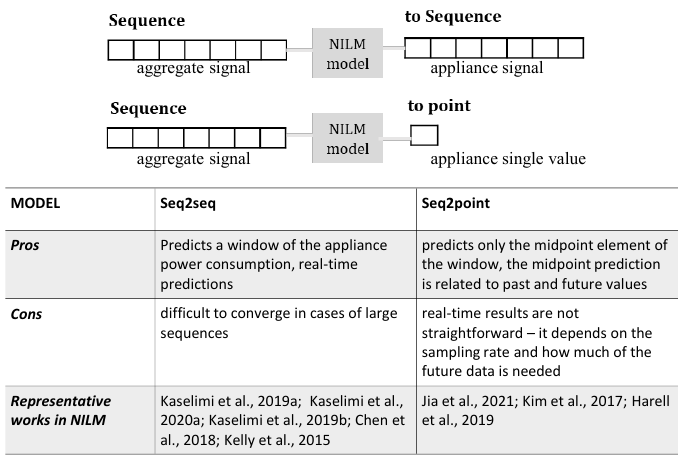
Figure 8. Sequence-to-sequence versus sequence-to-point approaches for NILM